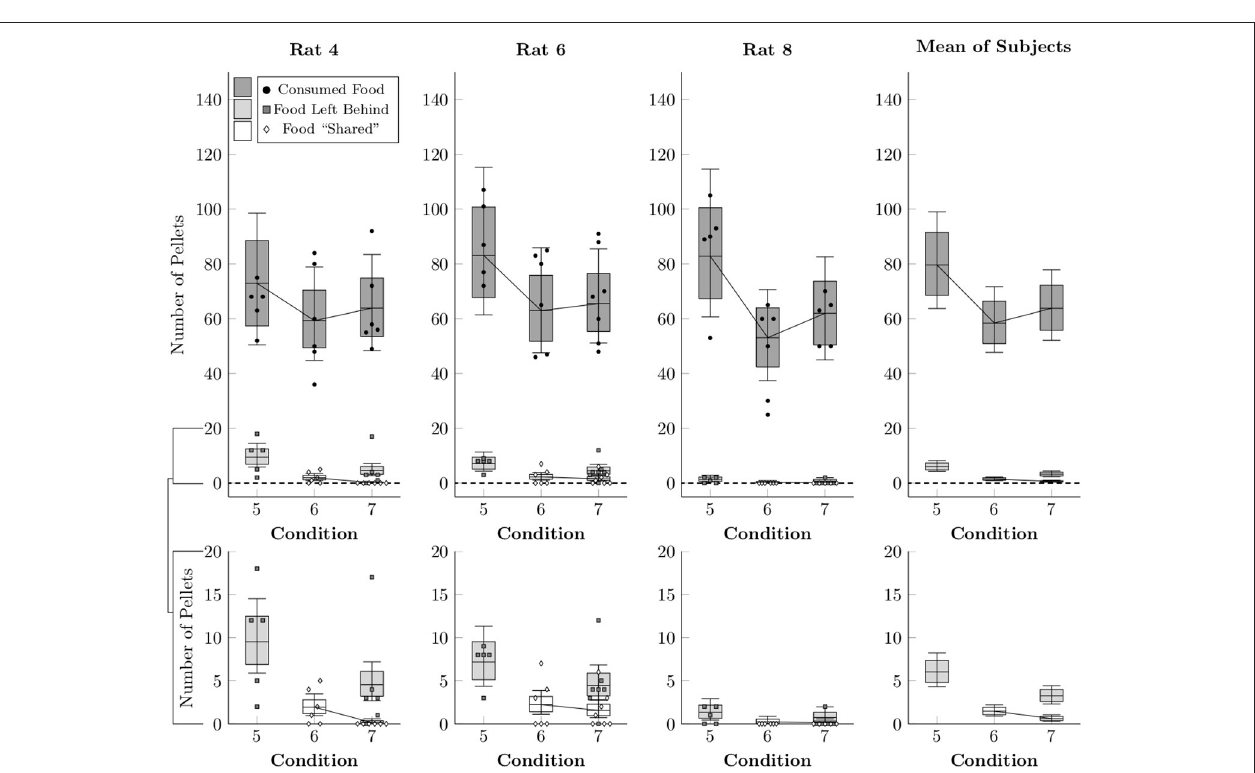
FIGURE 7 | Estimated number of pellets consumed by the focal rat (black circles), shared with the restrained rat (white diamonds), or left unconsumed by either rat (gray squares) in Conditions 5–7, as well as the mean of the subject estimates, based on a multi-level negative binomial regression. Points represent number of pellets in each category per session, whereas boxes represent the 80% credible interval and whiskers represent the 95% credible interval of the estimated